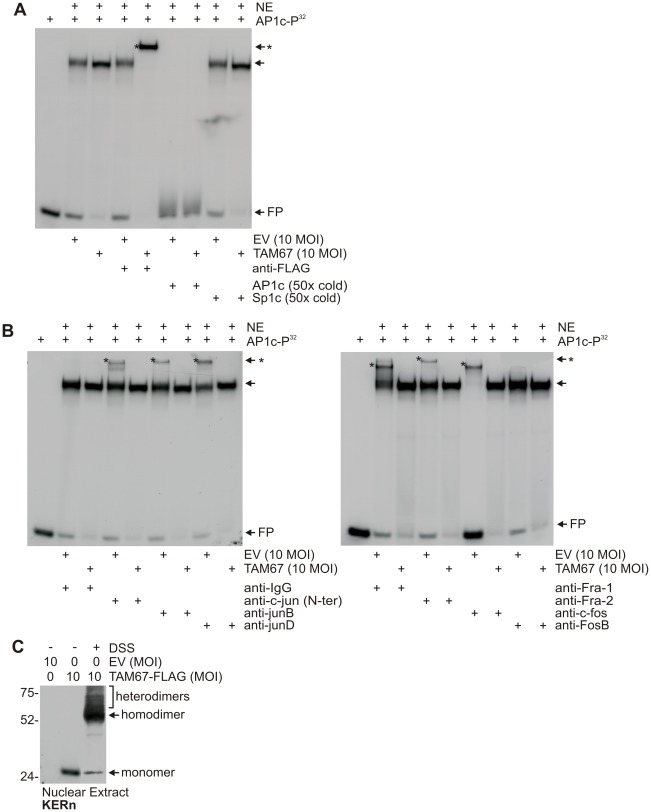
TAM67-FLAG inhibits AP1 factor binding to AP1 consensus DNA binding element.Keratinocytes were infected with 10 MOI tAd5-EV or tAd5-TAM67-FLAG and after 24 h nuclear extracts were prepared. A AP1 factors interact with AP1 consensus DNA element. Nuclear extracts were incubated with AP1c-P32 without or with a 50-fold molar excess of Sp1c or AP1c oligonucleotides, or anti-FLAG antibody and electrophoresed on a 6% acrylamide non-denaturing gel. FP indicates free probe and NE is nuclear extract. The arrow indicates the major shifted band and asterisks indicate migration of supershifted complexes. AP1c and Sp1c encode consensus AP1 and Sp1 binding elements. B TAM67-FLAG reduces AP1 factor binding to DNA. Nuclear extracts were incubated with AP1c-P32 in the absence or presence of c-jun, junB, junD, Fra-1, Fra-2, c-fos, or fosB antibodies, and electrophoresed on a 6% acrylamide non-denaturing gel. Arrows indicate shifted band and asterisks supershifted bands. FP indicates free probe. C TAM67-FLAG forms homodimers and heterodimers. Nuclear extracts were treated with or without DSS crosslinker prior to electrophoresis on a denaturing 8% polyacrylamide gel and TAM67-FLAG was detected by anti-FLAG immunoblot. Identical results were observed in three repeated independent experiments.